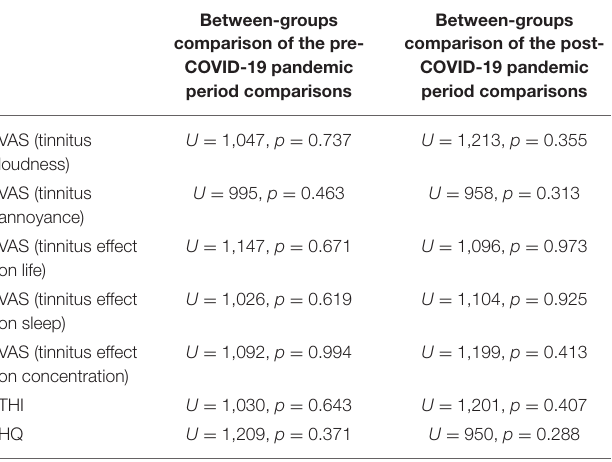
TABLE 2 | Comparison between COVID-19-positive and negative tinnitus patients concerning the pre-, and post-pandemic mean scores of VAS (tinnitus loudness, annoyance, effect on life, sleep, and concentration), Tinnitus Handicap Inventory (THI), and the Hyperacusis Questionnaire (HQ). Between-groups Between-groups comparison of the pre- comparison of the post- COVID-19 pandemic period comparisons